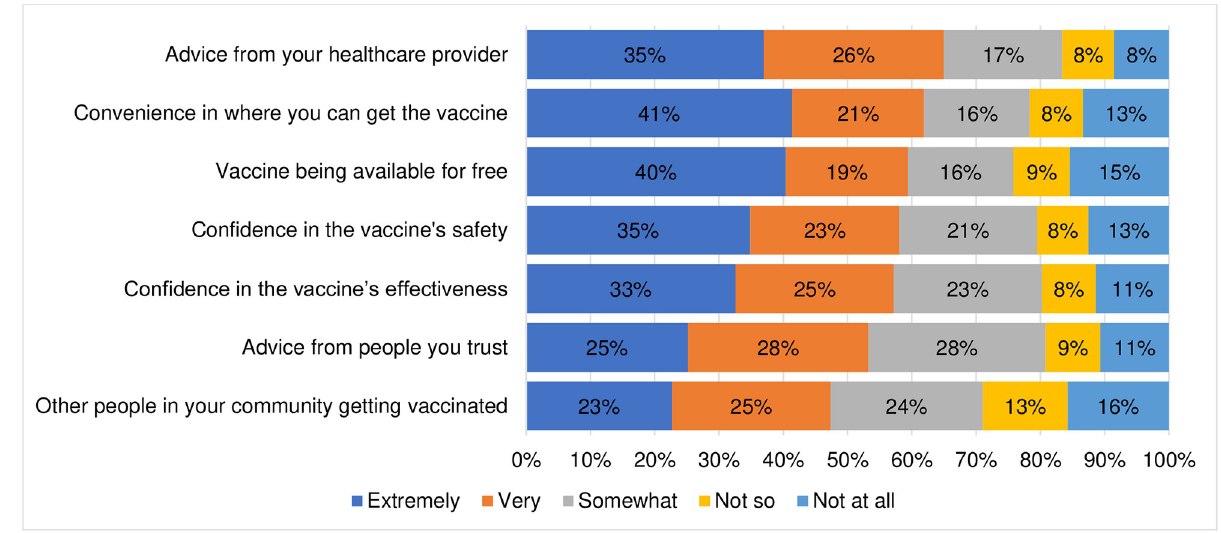
Fig 3. Decision to be vaccinated with the COVID-19